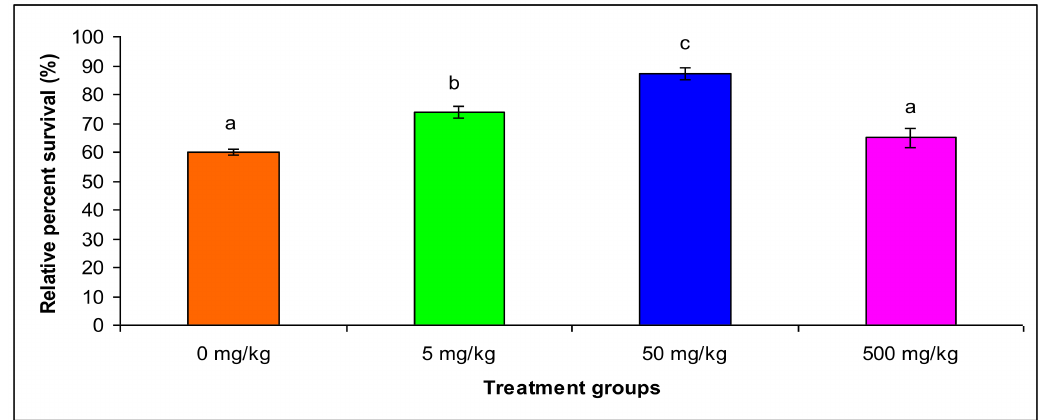
Figure 8. Effect of methanol extract of C. aerea algae administered on the percentage mortality in L. rohita challenged with virulent E. tarda (values are mean ± SE). Mean values with different superscript within a column for a parameter are significantly different ( p <